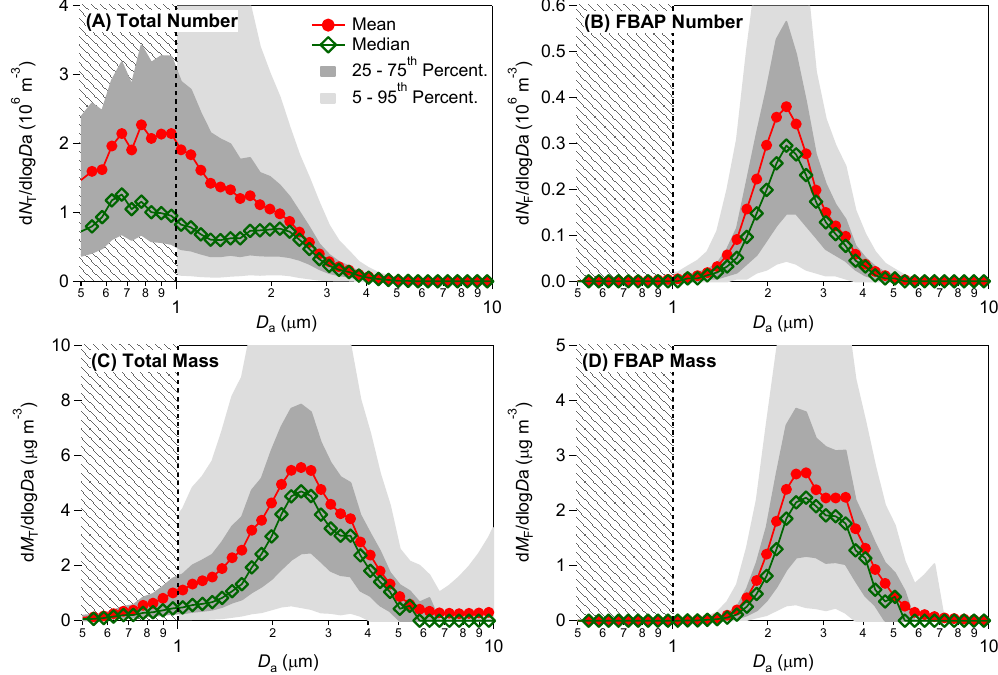
Fig. 2. Average particle number and unit-normalized mass size distributions for the measurement campaign (all points in Fig. 1). Hatched area indicates that only particles larger than 1.0µm were integrated for number and mass concentrations. (A) total number (d N T /dlog D a ) ,